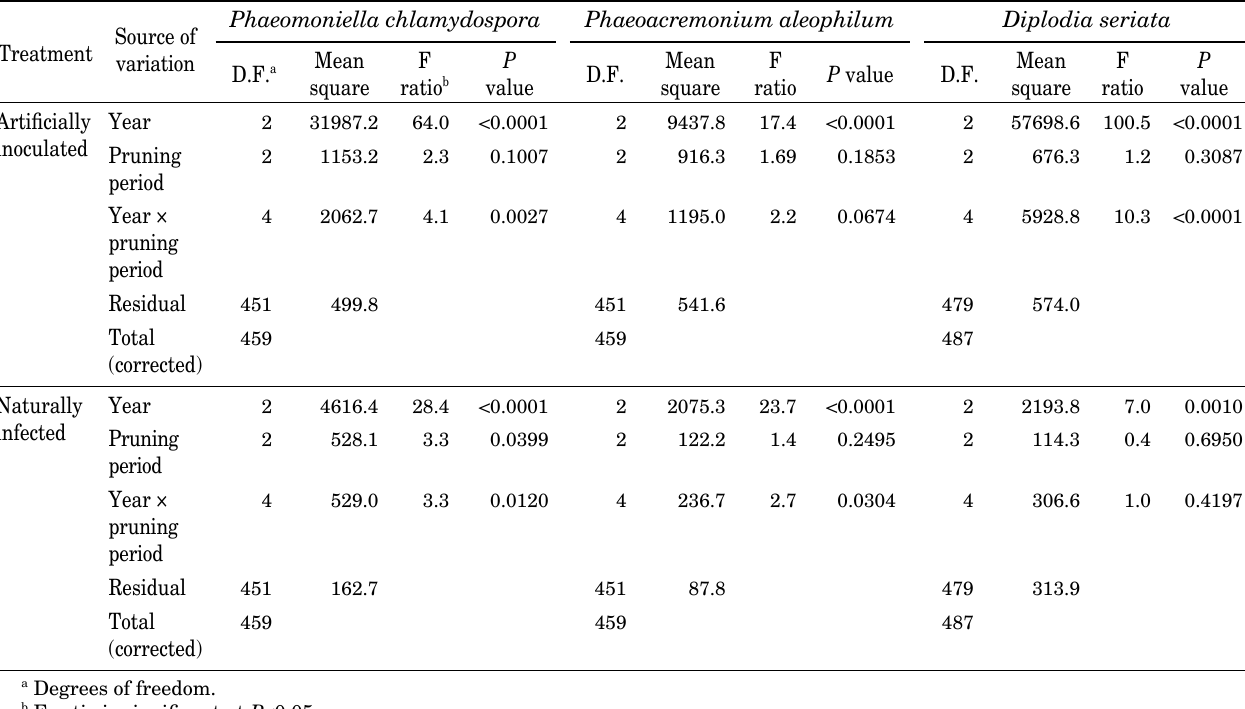
Table 1. Analysis of variance for year and pruning period on the percentage of infected spurs arti fi cially inoculated or